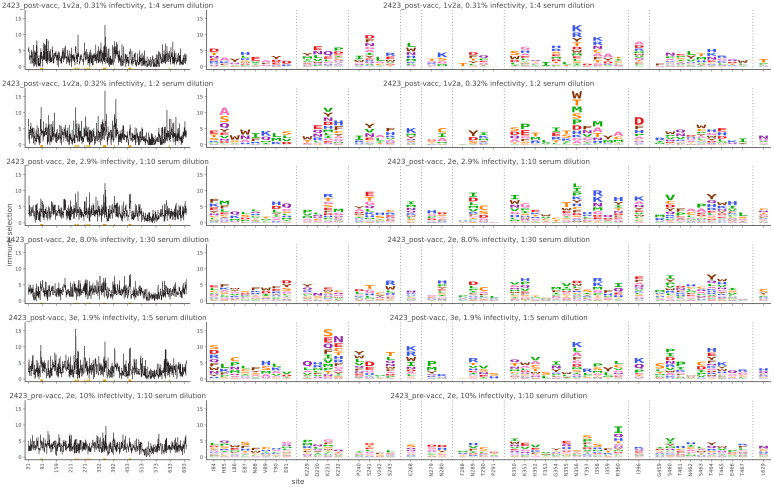
Mutational antigenic profiling data plotted for each individual replicates of pre- and post-immunization sera from rabbit 2423.Data are plotted as in Figure 2A,B for each, but with mutations colored according to their biochemical property rather than epitope.